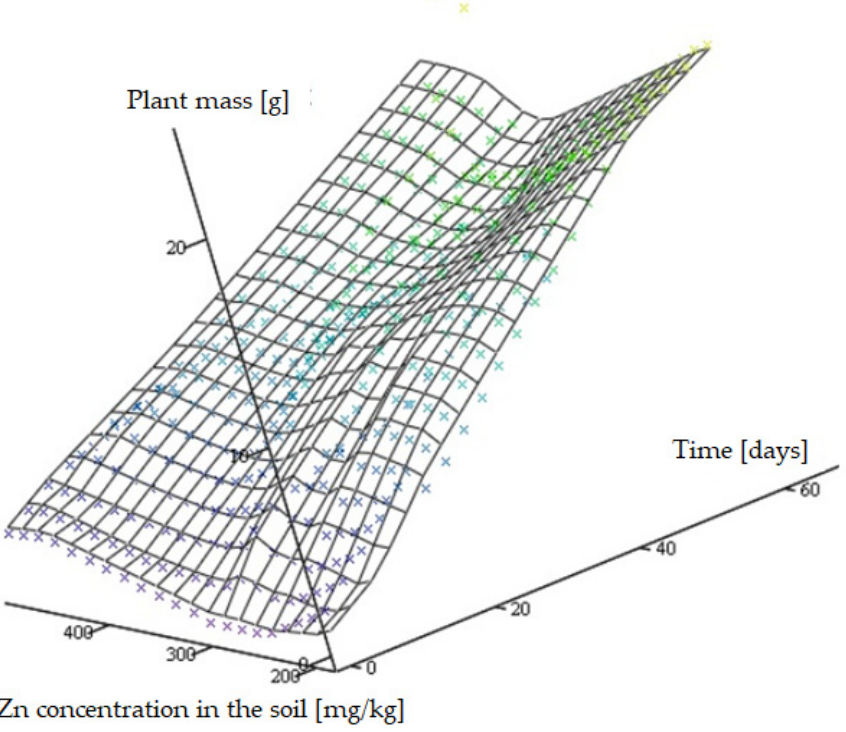
Figure 9. Variation of lettuce mass with time and the concentration of Zn in the soil, as a three- dimensional surface, corresponding to a third-degree polynomial interpolation.